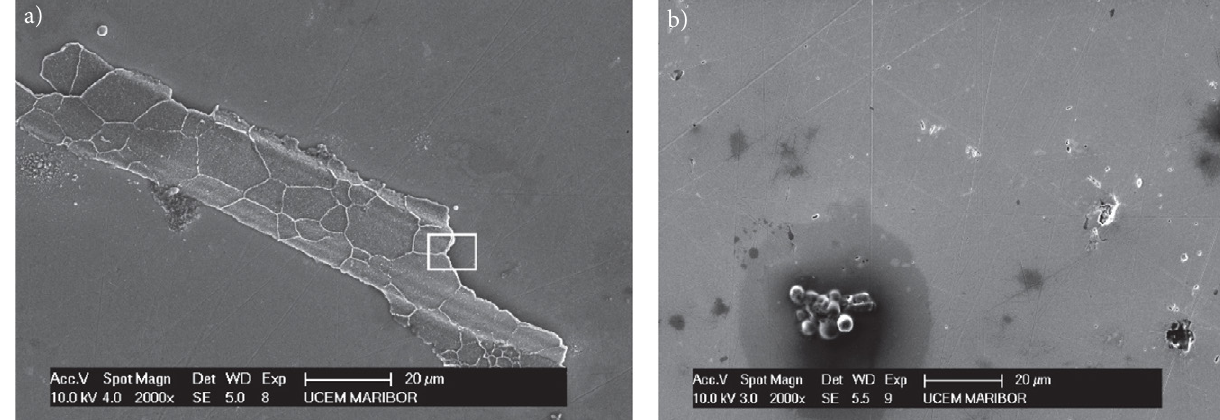
Figure 3. SEM images for AISI 347 at 75 °C and pressure: a) 100 bar and b) 300 bar.